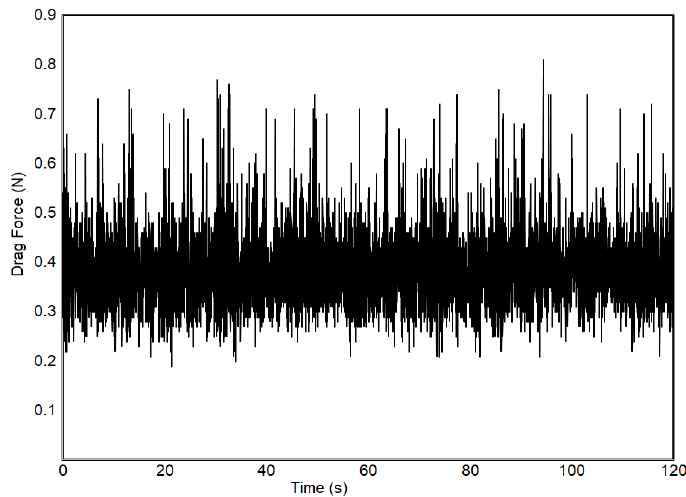
Figure 17. This graph shows typical force data collected during a test. For this data, the time-averaged velocity is 0.594 ± 0.01 m/s (not shown), while the time-averaged force is 0.386 ± 0.072 N. The sample is 16 mm cylinder bar using data sampling of 50 Hz.